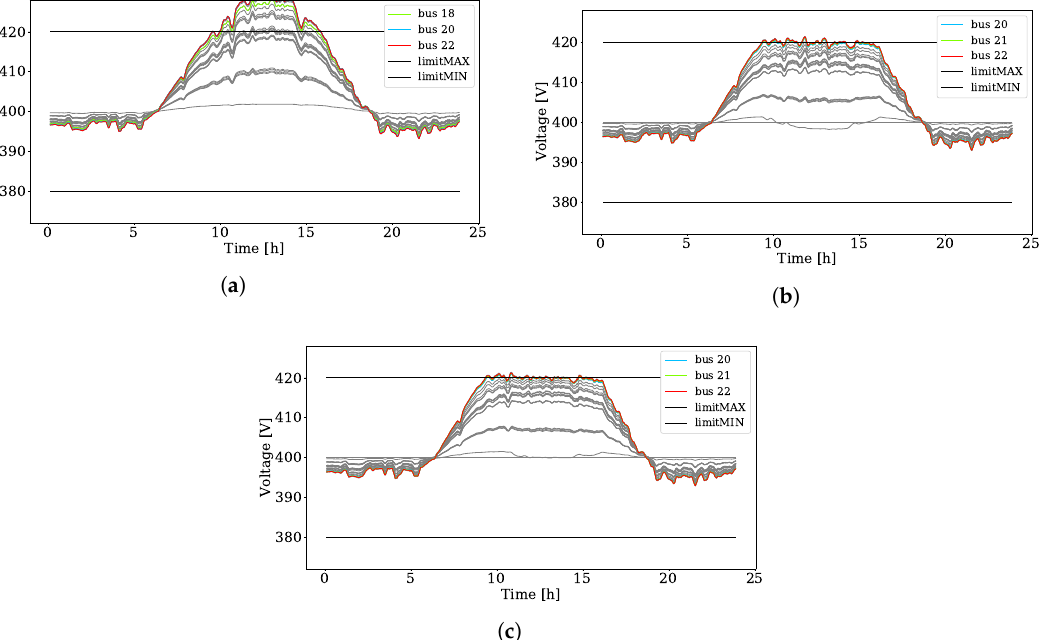
Figure 7. Voltage profile of the grid for different control strategies under clear sky conditions. ( a ) No control ( b ) Only DG control ( c ) Both DG and ESSs